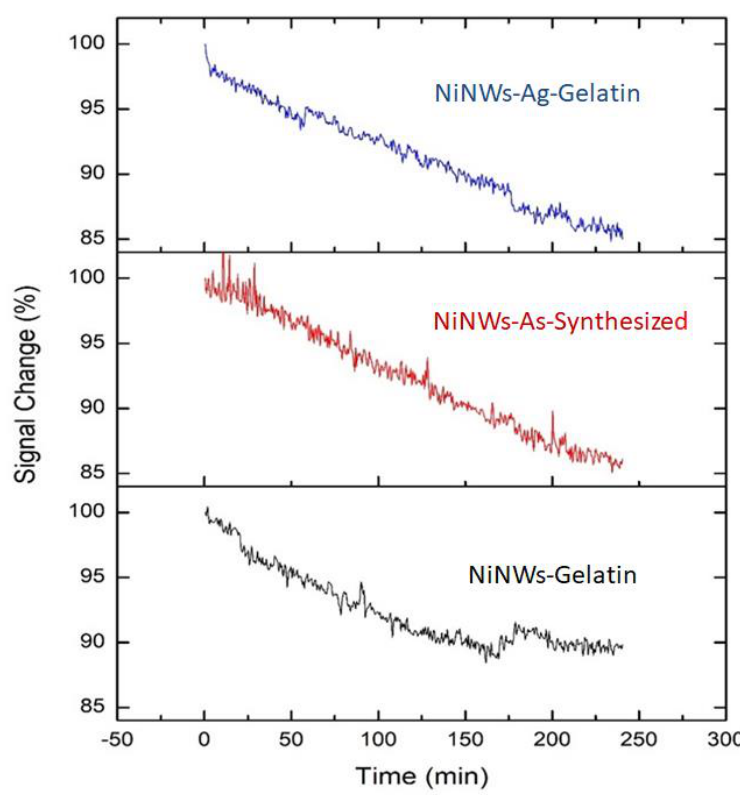
Figure 6. Signal change in